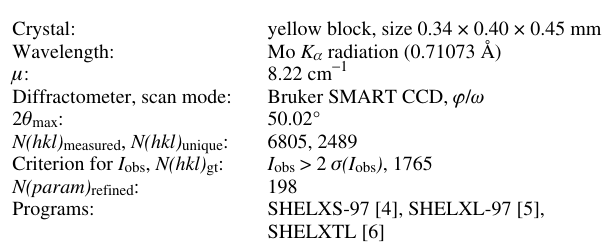
Table 1. Data collection and handling.